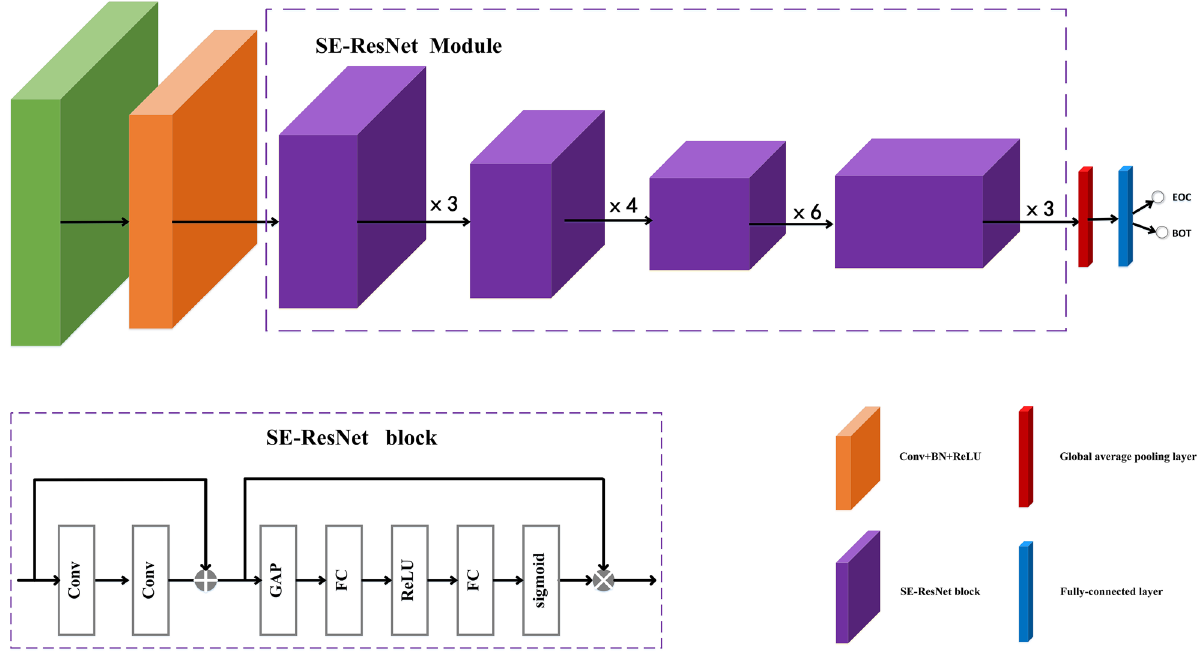
Figure 4. The structure of SE-ResNet-34 network. It comprised one convolutional layer, SE-ResNet Module, a global average pooling layer (GAP), and a fully-connected (FC) layer. In the SE-ResNet block, input features went through two convolutional layers and were added with original input features. All convolutional layers were followed by batch normalization (BN) layer and ReLU. Then, the features were fed into the GAP layer, and went through two FC layers followed by ReLU and sigmoid activation function to generate per-channel weights. The output of SE block is obtained by multiplying input features with the learned weights.